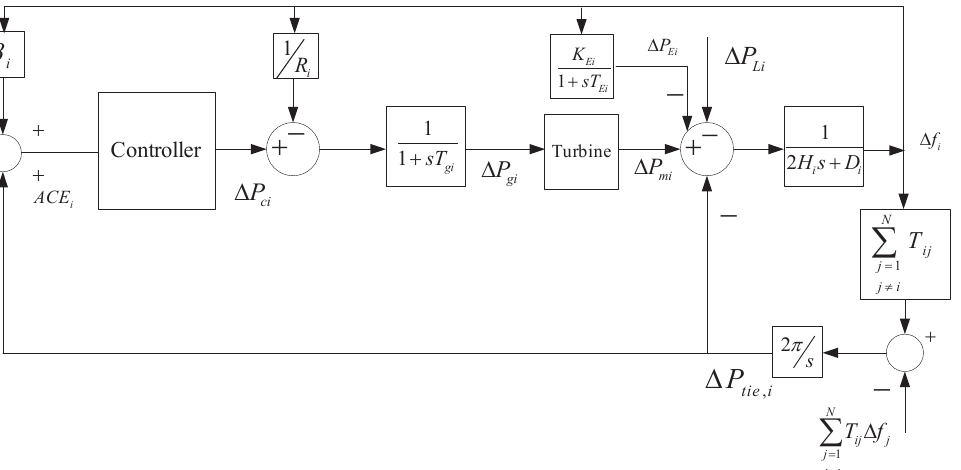
Figure 1. Block diagram of ith control area of vehicle-to-grid (V2G) system without state of charge